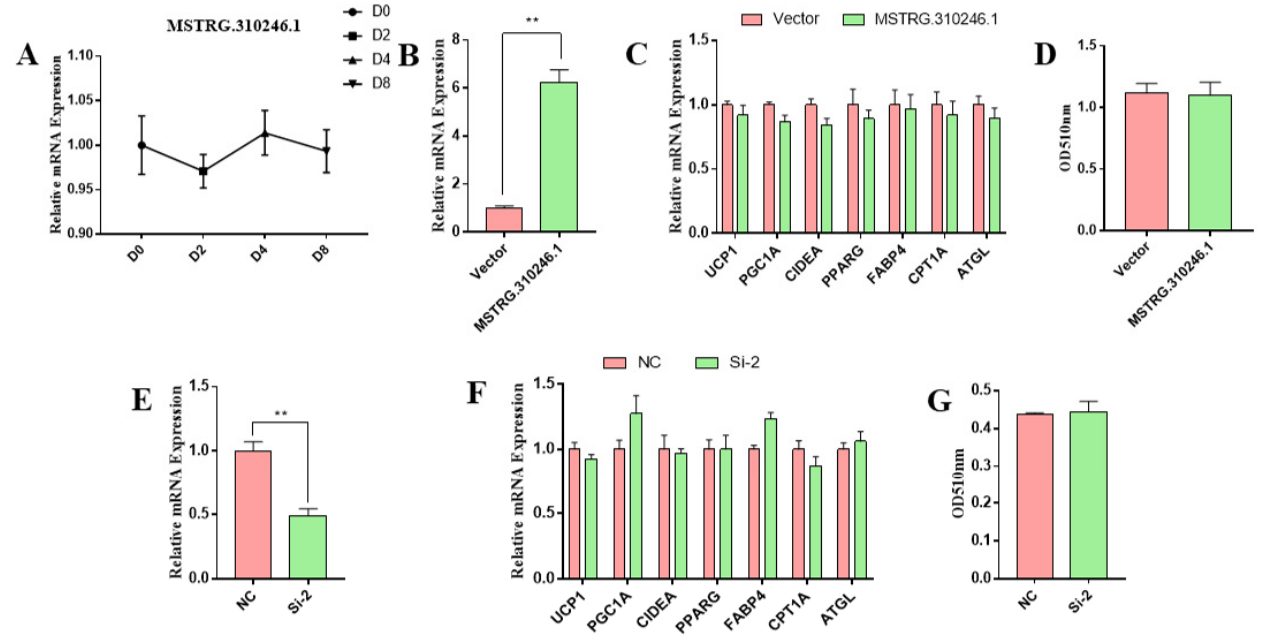
Figure 4. MSTRG.310246.1 had no effect on differentiation and thermogenesis in white adipocytes. ( A ) The expression pattern of MSTRG.310246.1 during the differentiation of white adipocytes. ( B ) Overexpression of MSTRG.310246.1 in white adipocytes. ( C ) Gene expression in white adipocytes transduced with MSTRG.310246. ( D ) The absorbance at 510 nm of oil-red-O staining of brown adipocytes transduced with vector or MSTRG.310246. ( E ) Knockdown of MSTRG.310246.1 in white adipocyte. ( F ) Gene expression in white adipocytes transduced with inhibitor NC or MSTRG.310246 inhibitor. ( G )The absorbance at 510 nm of oil-red-O staining of brown adipocytes transduced with inhibitor NC or MSTRG.310246 inhibitor. Error bars represent SEM, n = 6, ** p <